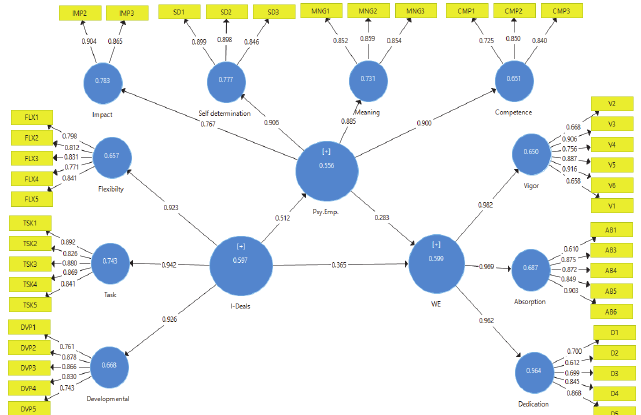
Fig. 2 . The results of testing the hypotheses